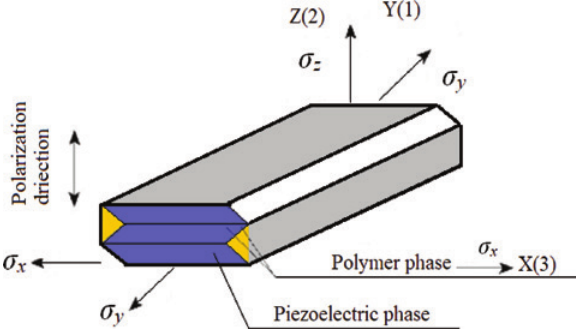
Figure 1: 1-1 OPCM longitudinal actuator element.